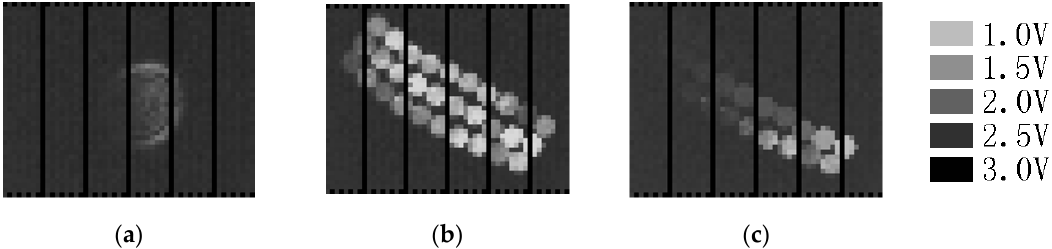
Figure 7. Images captured by the designed image sensor. ( a ) Image of the defocused laser spot used in the small signal responsivity measurement; ( b ) Image of the fiber bundle at a 17 ns shutter time. ( c ) Image of the fiber bundle at a 30 ps simulated shutter control signal delay.